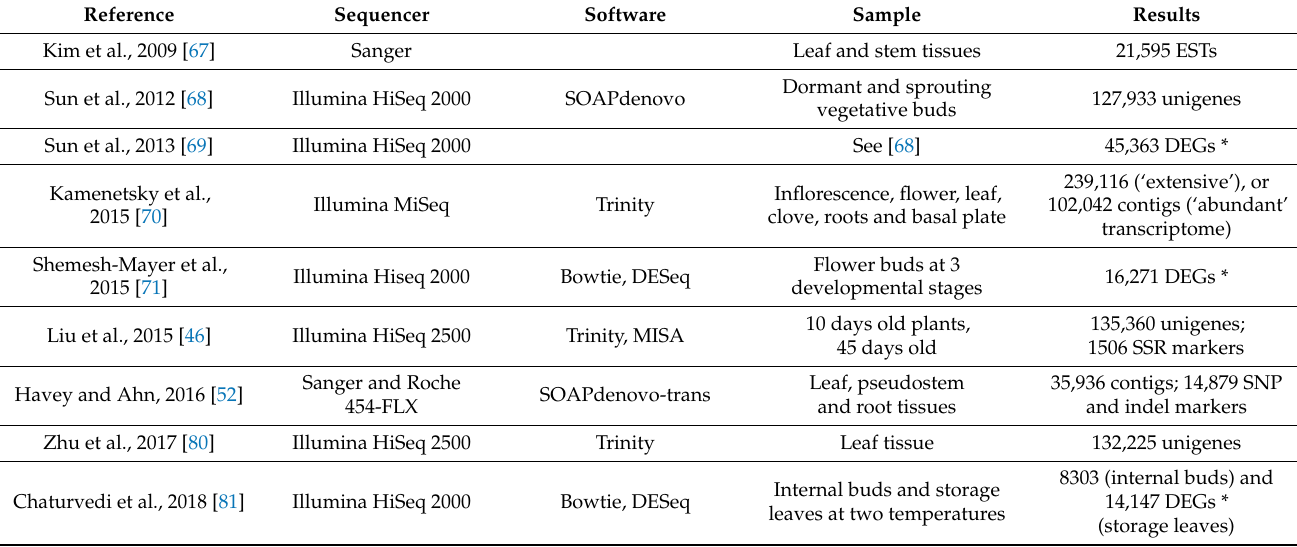
Table 2. Transcriptome studies using